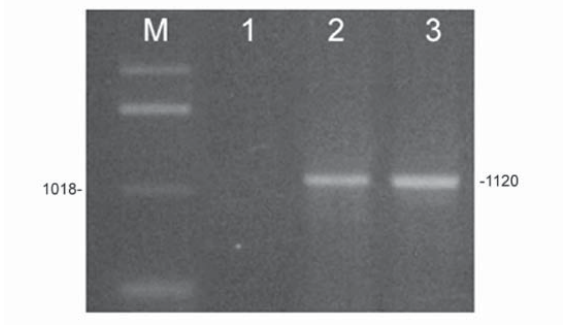
Fig. 2. Agarose gel electrophoresis of RT-PCR products of pac 1 mRNA isolated from transgenic potato plants: M, DNA molecular weight marker; 1 untransformed po- tato; 2, 3 transformed clones (A and B, respectively).